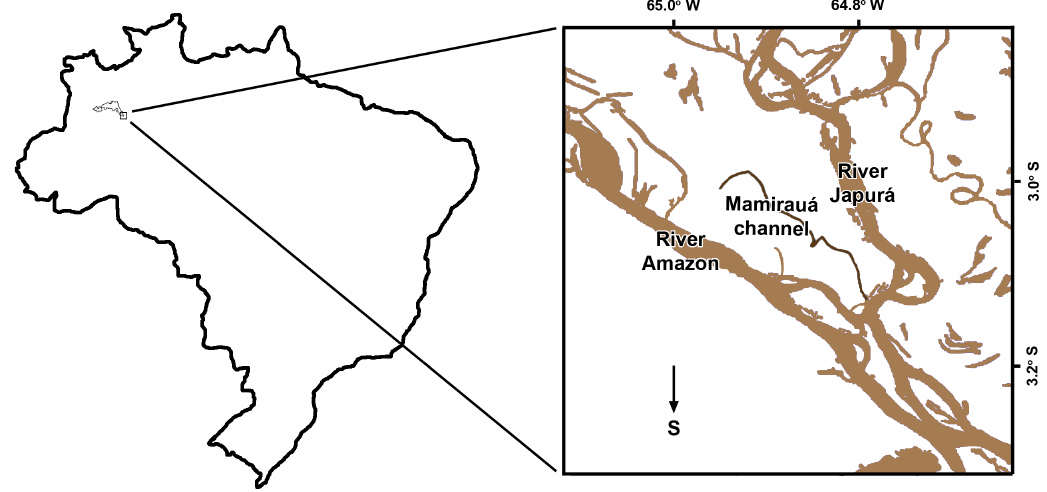
Fig 1. Map of Brazil, showing the location of the study site and (inset) the Mamiraua´ channel